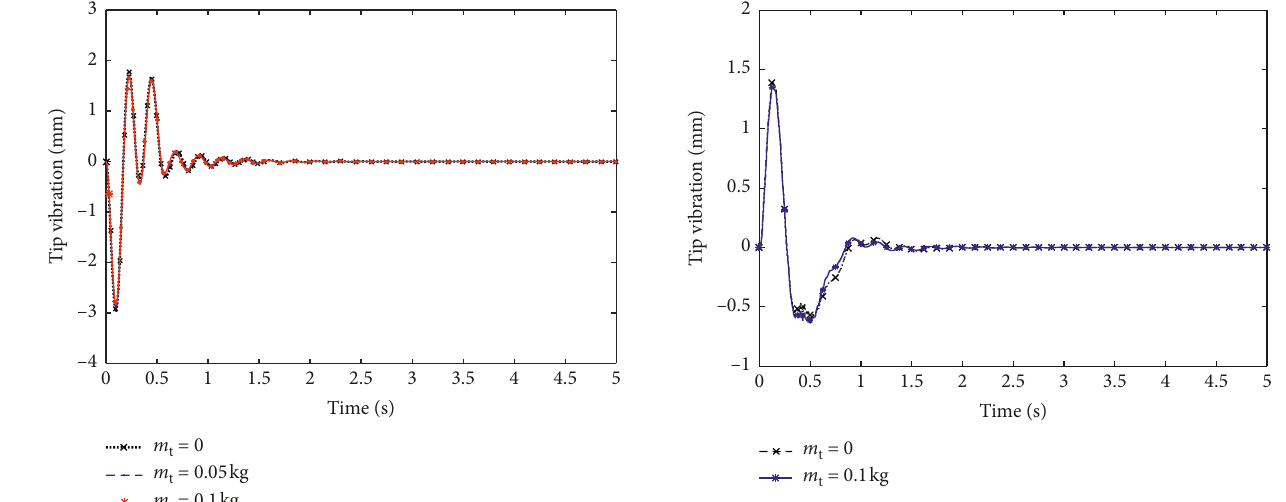
Figure 13: Vibration suppression effect of the flexible manipulator under variable load conditions by the combined